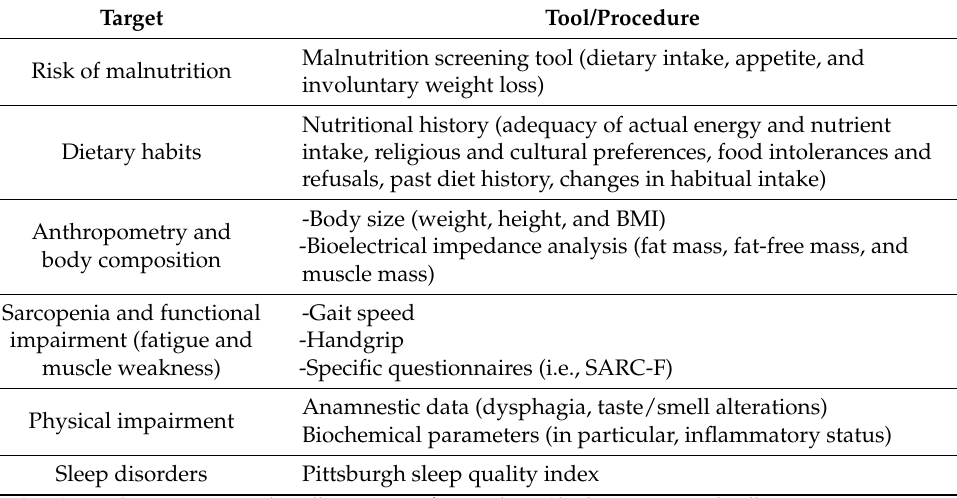
Table 1. Summary table of the tools/procedures for nutritional assessment in patients with post- COVID-19 syndrome. Target Tool/Procedure Malnutrition screening tool (dietary intake, appetite, and Risk of malnutrition involuntary weight loss) Nutritional history (adequacy of actual energy and nutrient Dietary habits intake, religious and cultural preferences, food intolerances and refusals, past diet history, changes in habitual intake) -Body size (weight, height, and BMI) Anthropometry and -Bioelectrical impedance analysis (fat mass, fat-free mass, and body composition muscle mass) Sarcopenia and functional -Gait speed impairment (fatigue and -Handgrip muscle weakness) -Specific questionnaires (i.e., SARC-F) Anamnestic data (dysphagia, taste/smell alterations) Physical impairment Biochemical parameters (in particular, inflammatory status) Sleep disorders Pittsburgh sleep quality